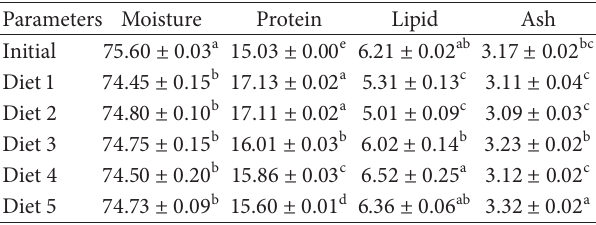
Table 6: Body composition of C. gariepinus fed diets containing variousamountsofdriedbrewer’syeastsubstitutedforsoybeanmeal for 8